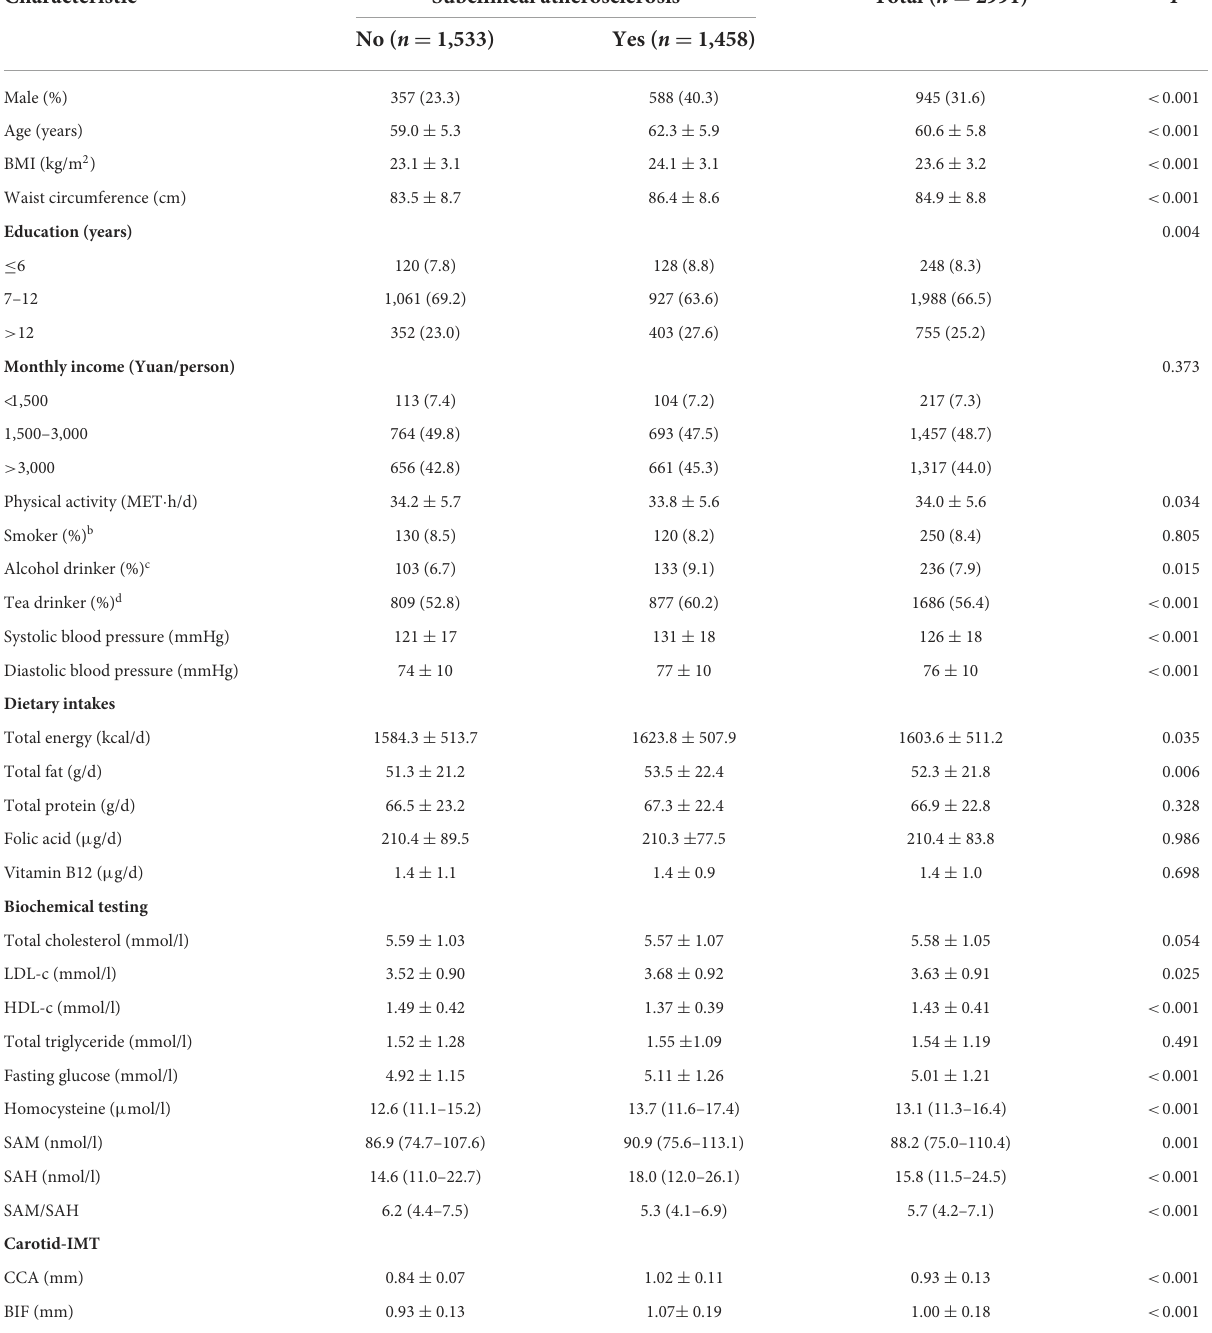
TABLE 1 Baseline characteristics and selected risk factors of the study participants by presence or not of subclinical atherosclerosis, Guangzhou Nutrition and Health Cohort ( n = 2,991) a . Characteristic Subclinical atherosclerosis